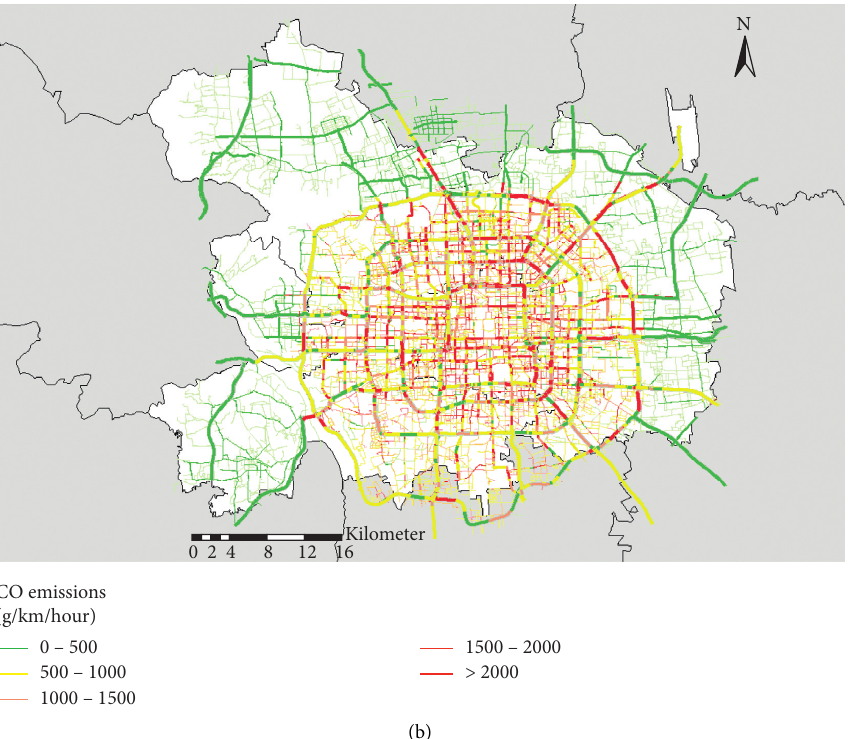
Figure 6: Model result for spatial and temporal distribution of flows and emissions in Beijing (8:00–9:00). (a) Traffic flows are estimated from the FCD of different road types. (b) The spatial distribution of CO